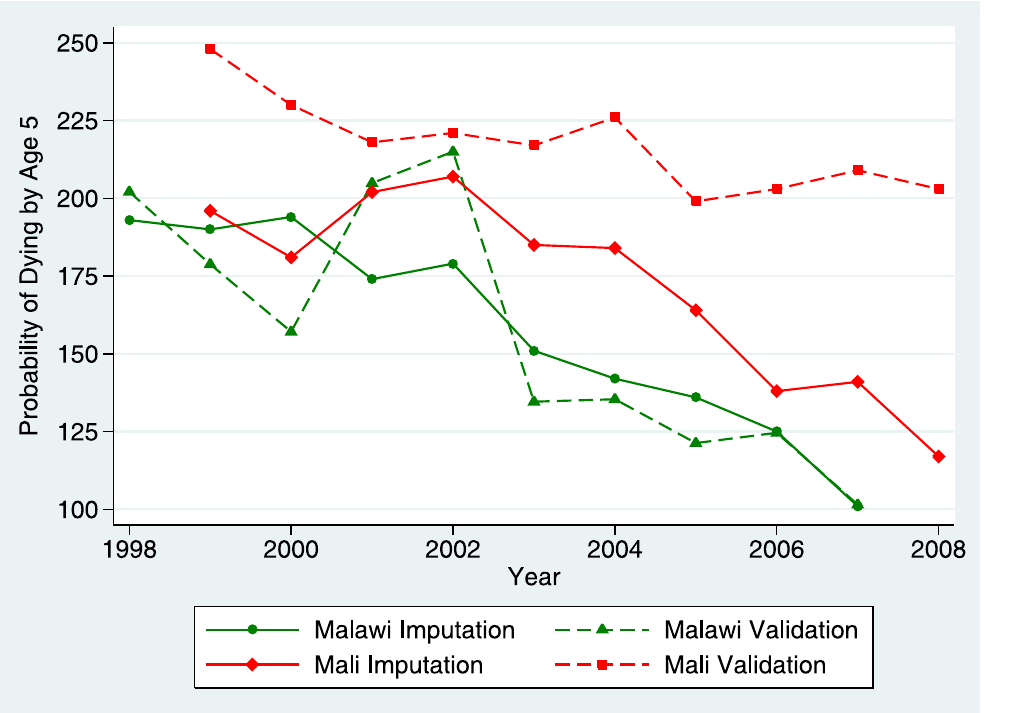
Fig 4. Annual estimates of U5MR from imputation and validation data sets: Malawi and Mali. This figure shows annual estimates of U5MR from the Birth History Imputation Method on the one hand and from the validation survey on the other for applications to Malawi and Mali.